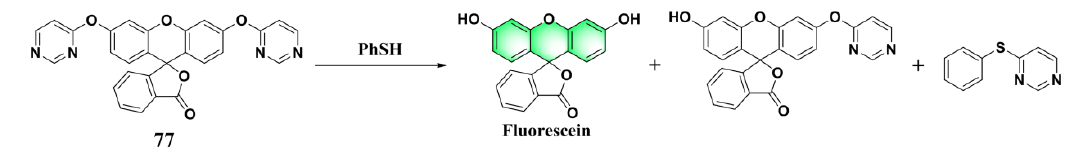
Figure 27. Structure and sensing mechanism of probe 77 for PhSH.